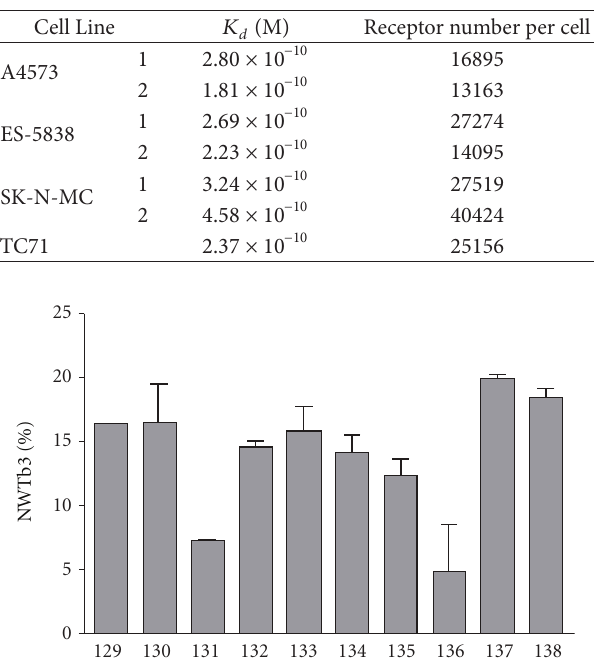
IR3 antibody and compared to 𝛼𝛼